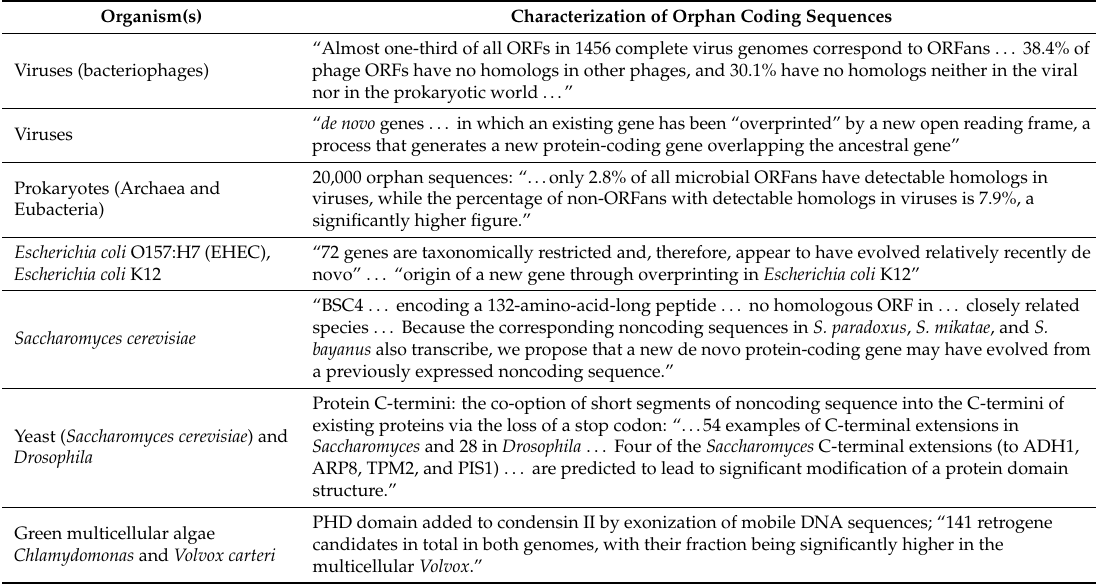
Table 10. Some Indepedently Reported Instances of Orphan Coding Sequences (“New Genes” and New Exons) Discovered in Sequenced Genomes. Organism(s) Characterization of Orphan Coding